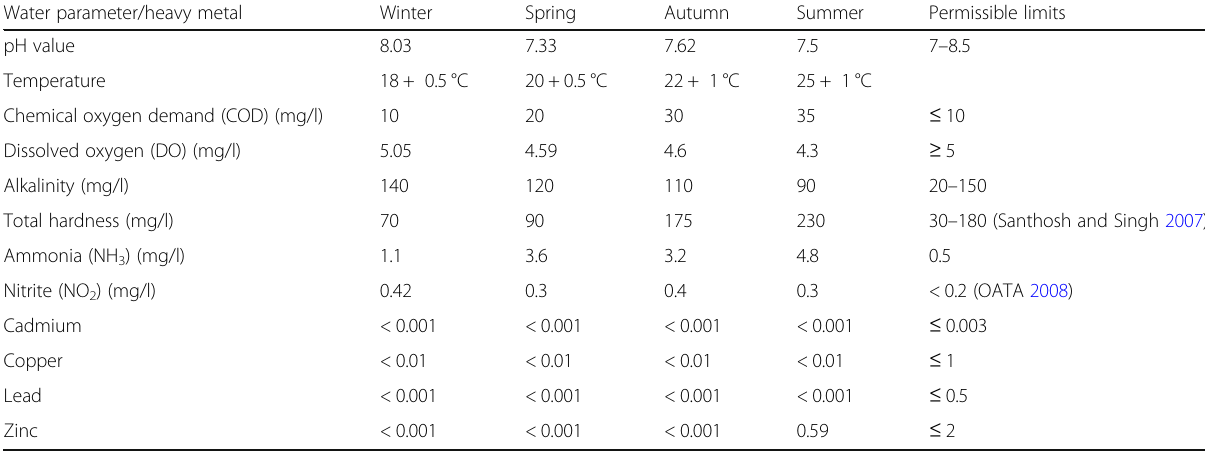
Table 2 Water parameters (mg/l) and seasonal variations of heavy metals concentrations (mg/l) in three water samples per season of fish cultures in Kafr El-Sheikh